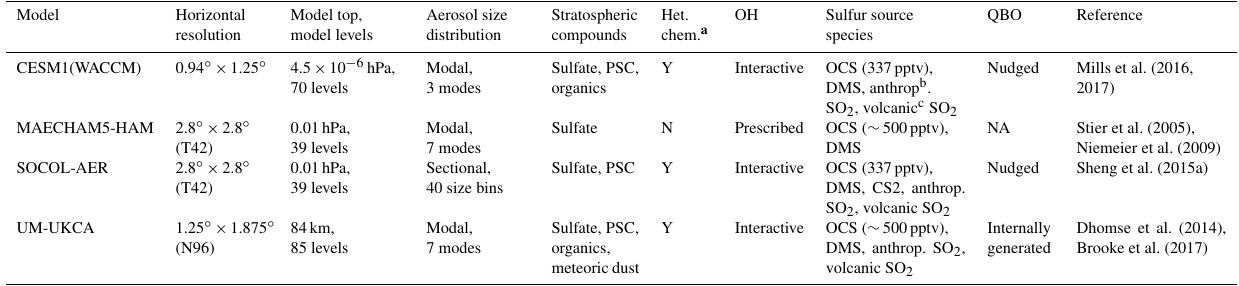
Table 1. Description of models, adapted from Kremser et al. (2016). Modal vs. sectional aerosol size distributions are described in the text. Model